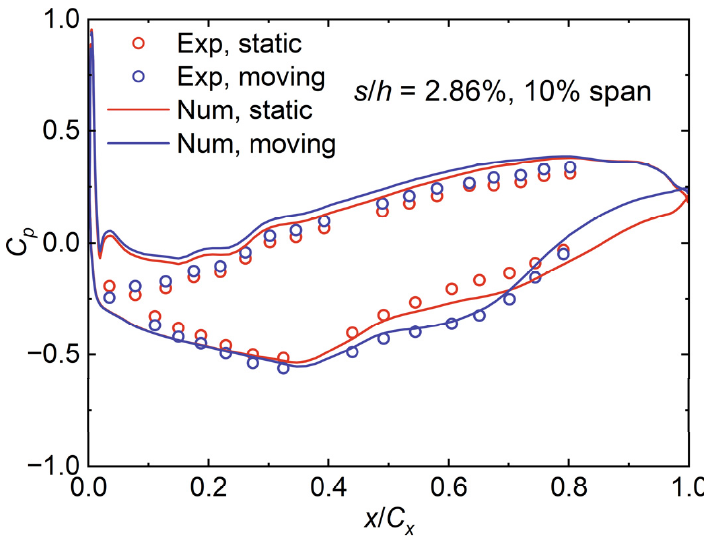
Figure 20. Distributions of static pressure coefficient.